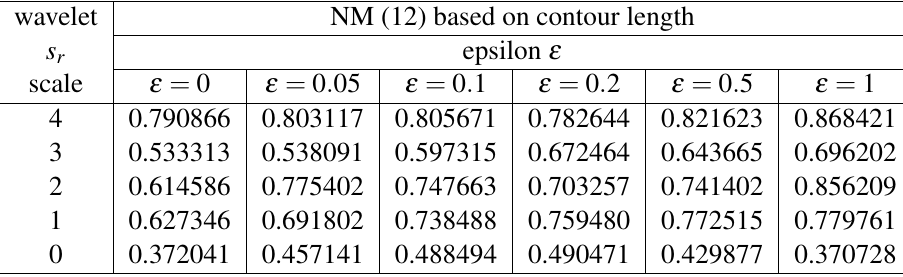
Table 5. Nearness Measures of B & L images based on contour lengths.